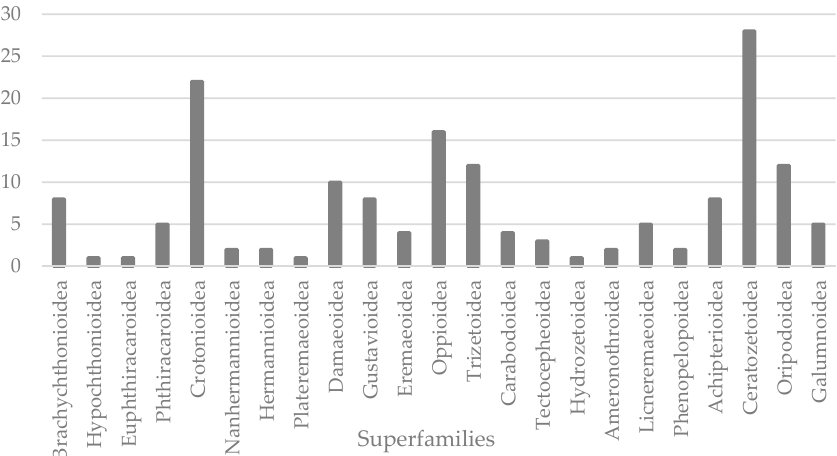
Figure 1. Distribution of species richness among different superfamilies of oribatid mites in the East European tundra (taxa are in a systematic order).